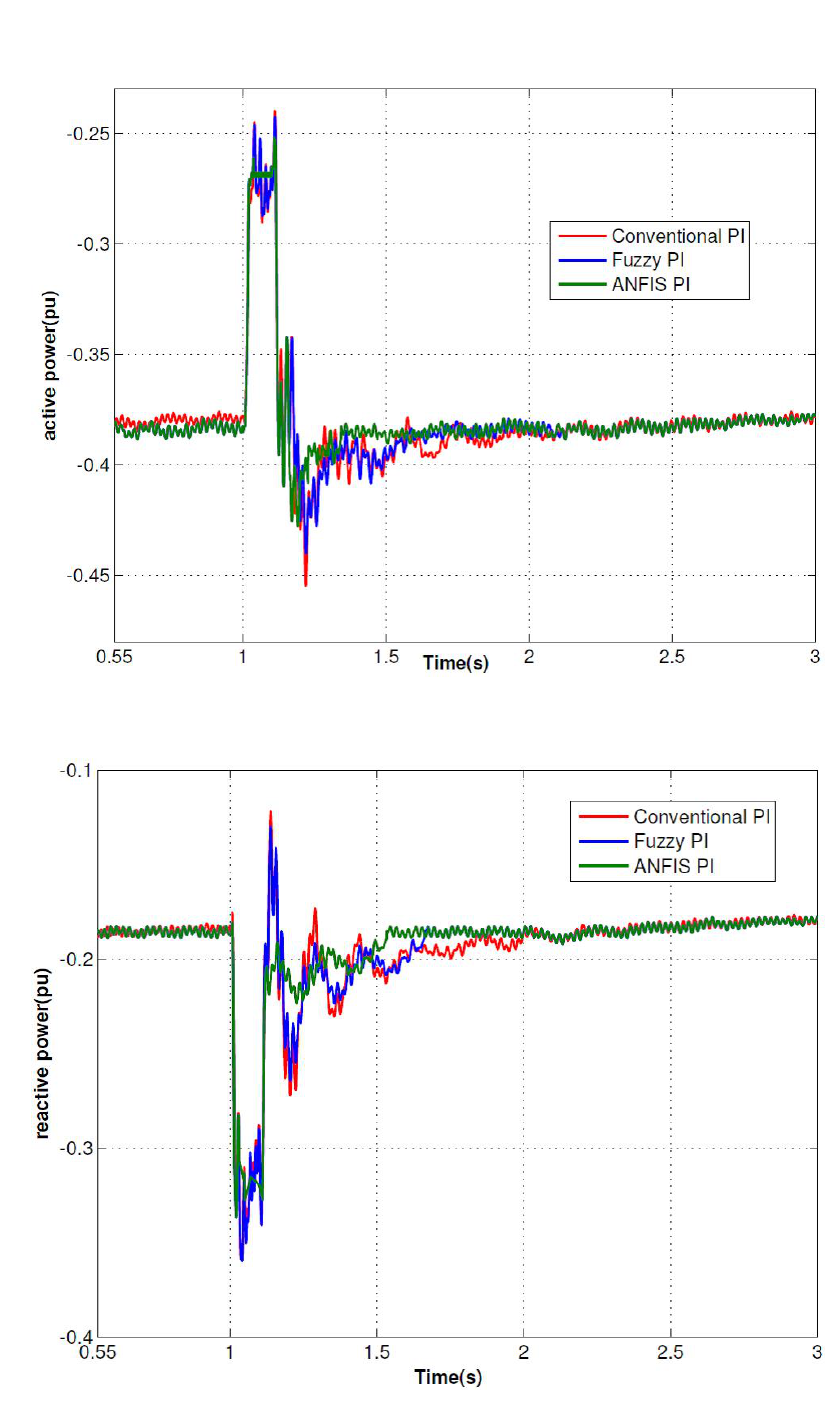
Figure 7. (a) Active power (b) reactive power at inverter AC bus for a 5 cycle line to ground fault on inverter side AC